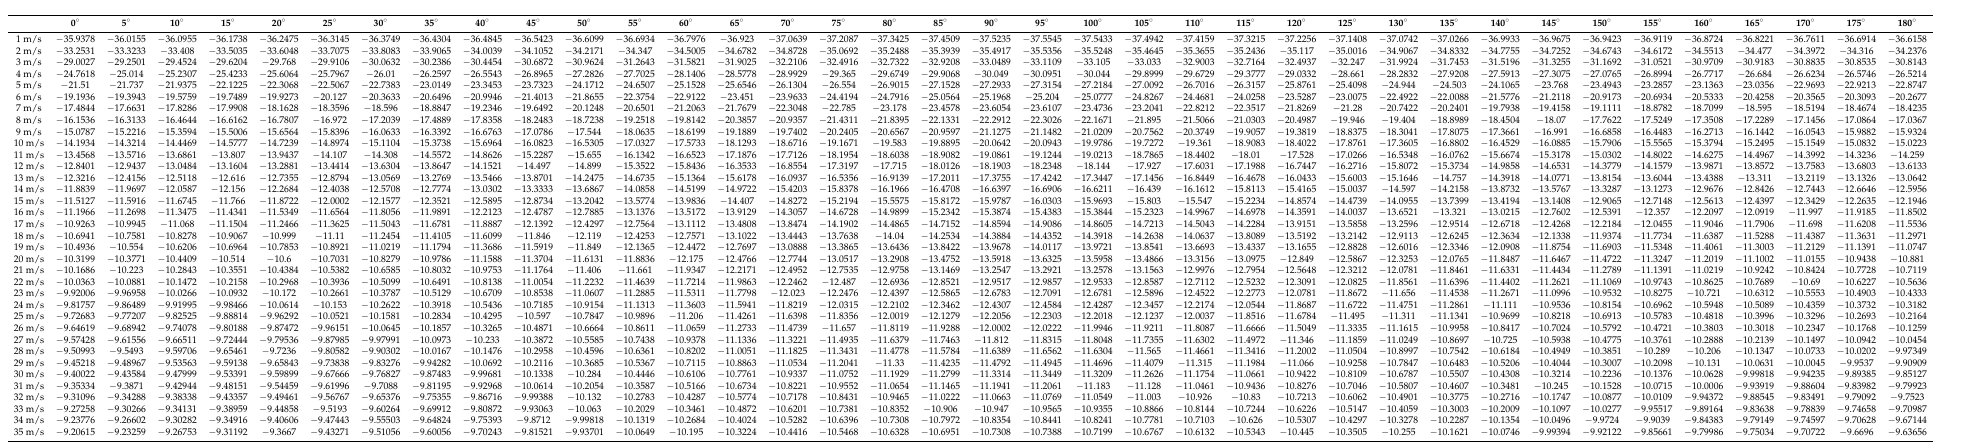
Table 4. The backscattering coefficients in HW-GMF of VV